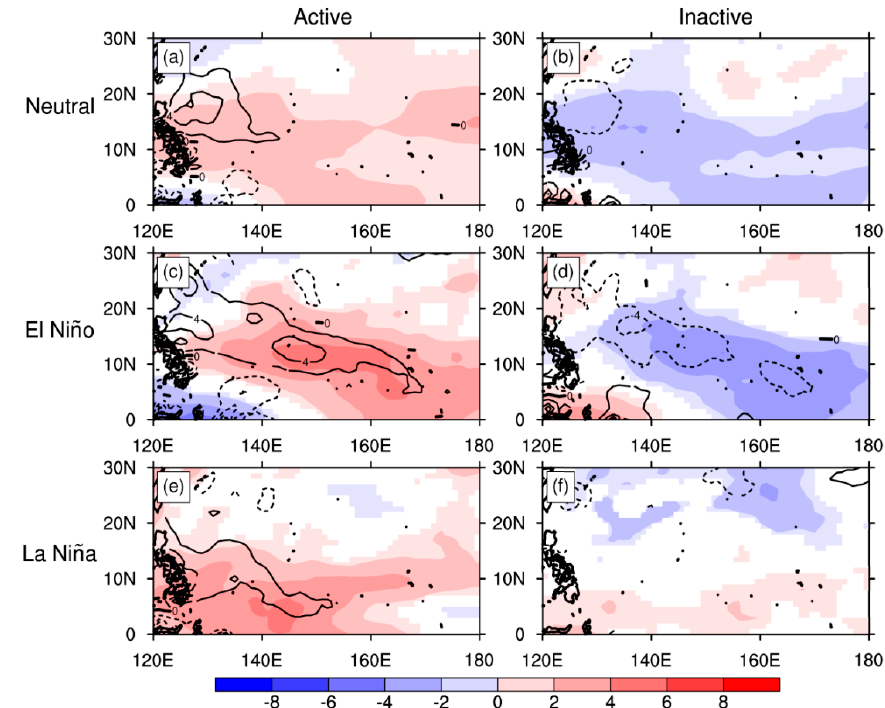
Figure 7. Composite of filtered 600 hPa relative humidity anomalies (shaded; unit: %) and filtered 850 hPa relative vorticity anomalies (contours; unit: 10 − 6 s − 1 ) during the ( a , c , e ) active and ( b , d , f ) inactive MJO phases for neutral years (top panels), the El Niño years (middle panels), and the La Niña years (bottom panels) over the WNP during June–November over the period of 1979–2016. Dashed (solid) contours, negative (positive) filtered anomalies of relative vorticity (interval 2 × 10 − 6 s − 1 ). Only values that exceeded the 90% confidence level are plotted. The definition of the active and inactive phases for the MJO-related WNP TC genesis under different ENSO conditions is in Table 1.